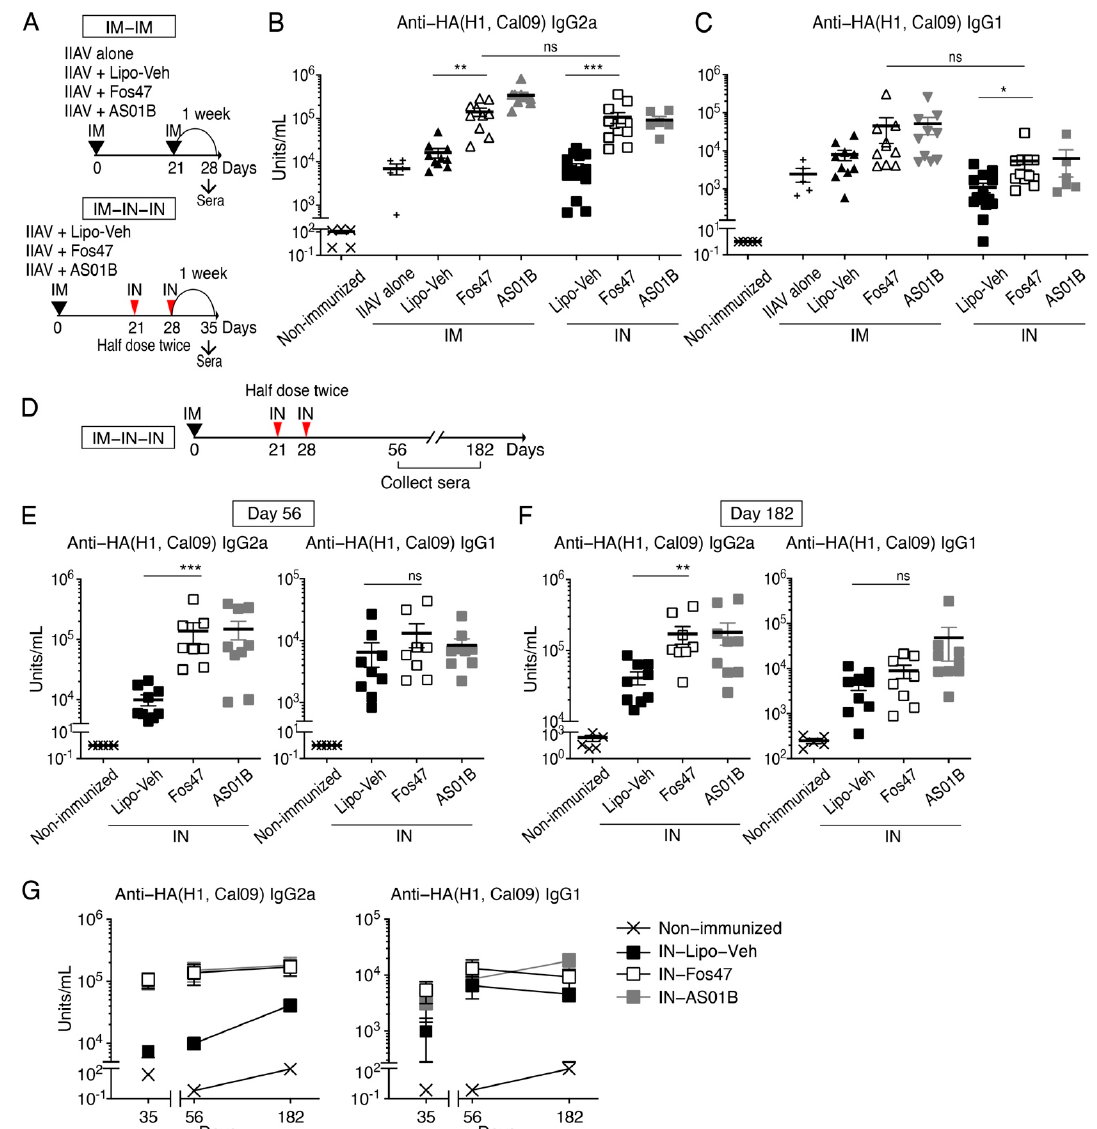
Figure 4. Antigen-specific IgG antibody titers induced by IN boosting with Fos47 were comparable to IM boosting with Fos47. ( A ) Experimental protocols of IM-IM and IM-IN-IN regimens. BALB/c mice were IM primed with IIAV plus Fos47 or Lipo- Veh (blank liposomes, negative control) in 50 μ L on day 0. For IM-IM regimen, the mice were IM boosted on day 21 with a full dose (50 μ L per dose). For IM-IN-IN regimen, the mice were IN administered with a half dose of the vaccine (25 μ L per dose) twice 7 days apart. Non-immunized (naïve) and IIAV alone served as negative controls. One week after the last boost, sera were collected to evaluate serum IgG2a and IgG1 against HA. ( B ) Anti-HA(H1, Cal09) IgG2a. ( C ) Anti-HA(H1, Cal09) IgG1. Bars indicate means ± SEM ( n = 6–12 group). * p < 0.05, ** p < 0.01, *** p < 0.001, ns; not significant, Kruskal–Wallis with Dunn’s post hoc test to compare 4 groups (IM-Lipo-Veh, IM-Fos47, IN-Lipo-Veh and IN-Fos47). ( D – F ) Long-term serological analysis of IM-IN-IN regimen. Female BALB/c mice ( n = 6–12/group) were IM primed on day 0 and IN boosted on days 21 and 28. HA(H1, Cal09)-specific IgG2a and IgG1 in sera were evaluated on days 56 ( E ) and 182 ( F ) ** p < 0.01, *** p < 0.001, ns; there was no significant difference, Mann–Whitney U -test to compare IN-Lipo-Veh and IN-Fos47. ( G ) Time course plots of antibody titers. The data for individual mice for days 35, 56 and 182 are presented in Figure 4B,C,E,F, respectively. Bars indicate means ± SEM ( n = 6–12 group). There was no significant difference between days 56 and 182 in each group by repeated measures two-way ANOVA with Holm–Sidak’s post hoc